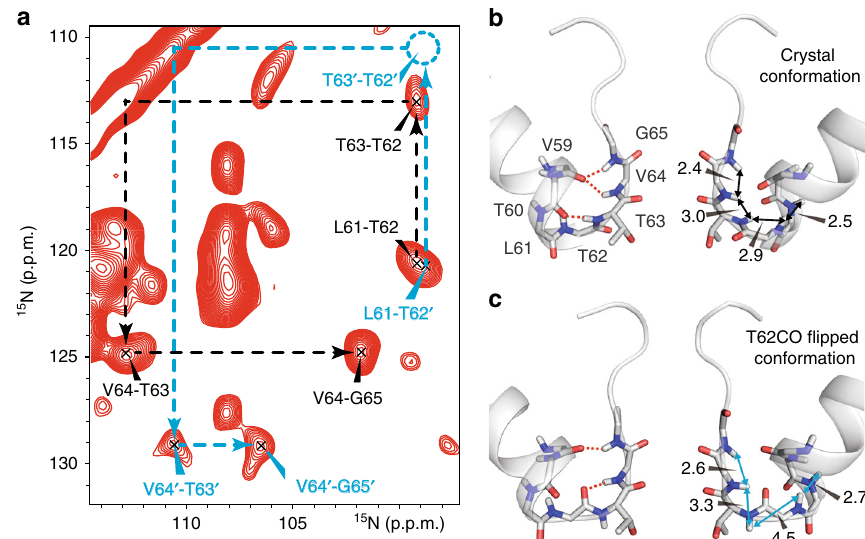
Fig. 3 Crystal and T62CO fl ipped conformations. a NHHN spectrum of NaK with 50 mM K + showing the ion-free (cyan) and K + /Rb + -favored (black) conformational states. The predicted position of the T63 ’ -T62 ’ cross-peak is circled in dashed cyan. b , c Hydrogen bond network in the crystal ( b ) and the fl ipped ( c ) conformations of NaK. Distances (Å) between adjacent amide protons are indicated and hydrogen bonds are shown with red dashed